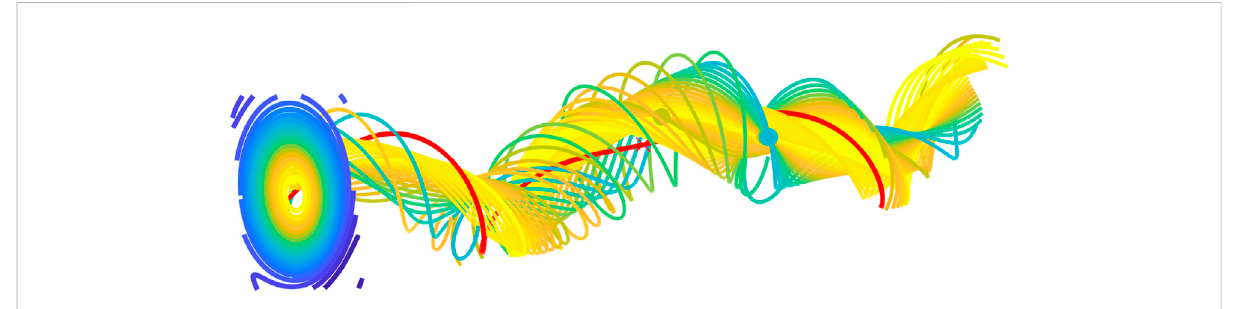
FIGURE 11 InexactlythesameviewasFigure10,selected fi eldlinescrossingthespacecraftpathsofSTAandPSP,andcolorcodedbythecorresponding B z values according to the colorbar of Figure 8B. The thick red line originates from the point with the maximum B z on the bottom